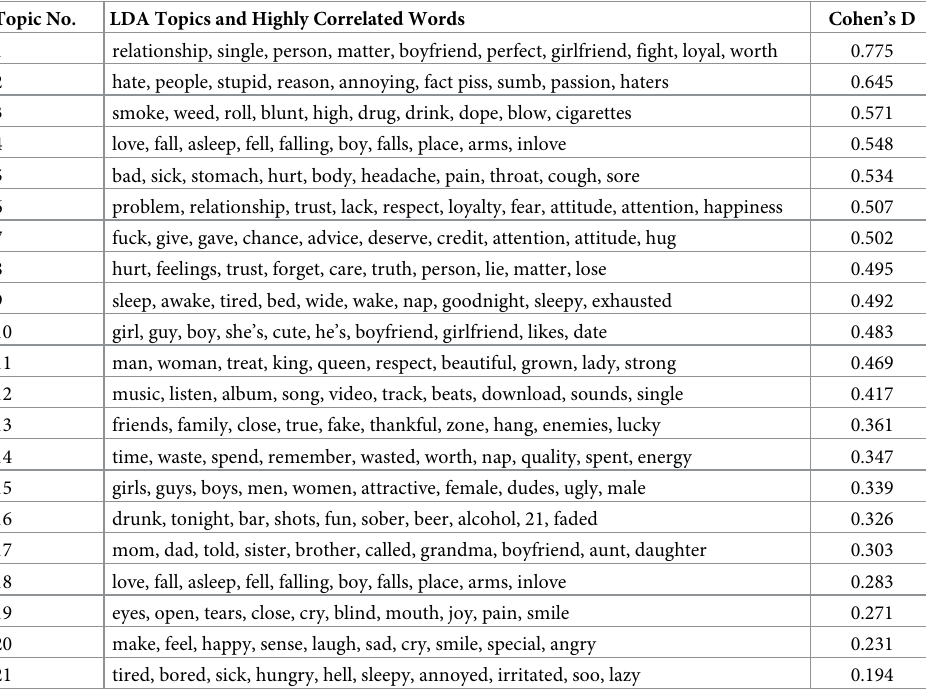
Table 7. Results from LDA analysis for male: 23—29. Topic No. LDA Topics and Highly Correlated Words